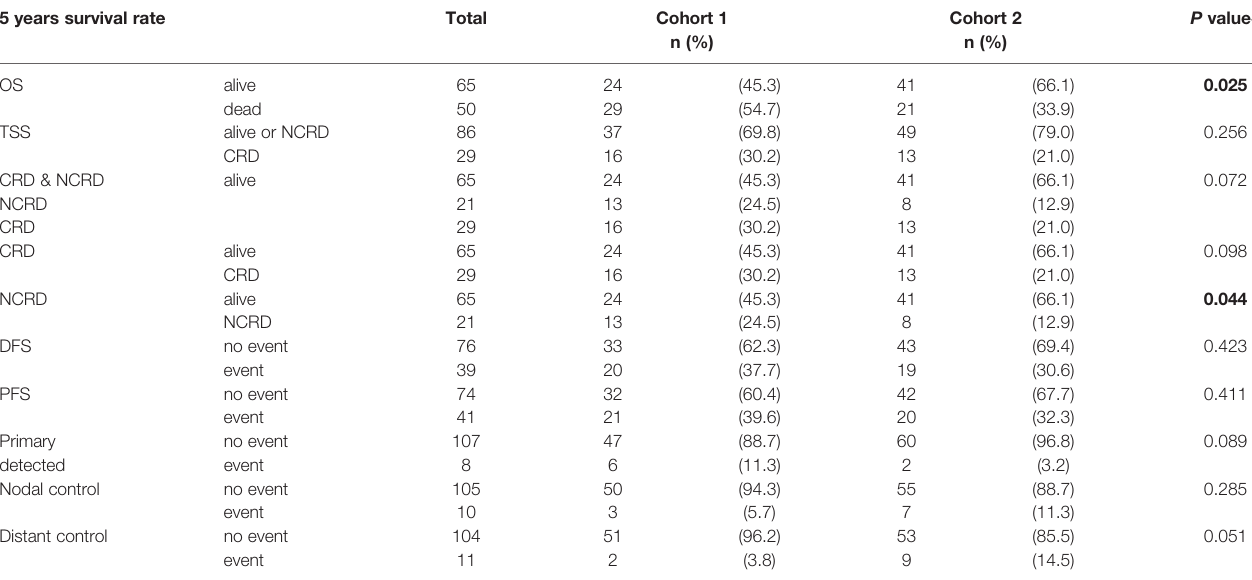
TABLE 3 | Various survival measures for 5-years outcome of neck squamous cell carcinoma of unknown primary (NSCCUP) patients of cohorts 1 and 2. 5 years survival